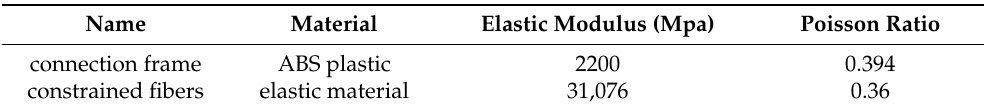
Table 3. Model parameters.